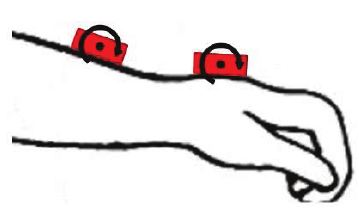
Figure 1 . Placement of MEMS gyroscopes (red boxes) for recording wrist flexion-extension. A differ- ential measurement directly provides wrist